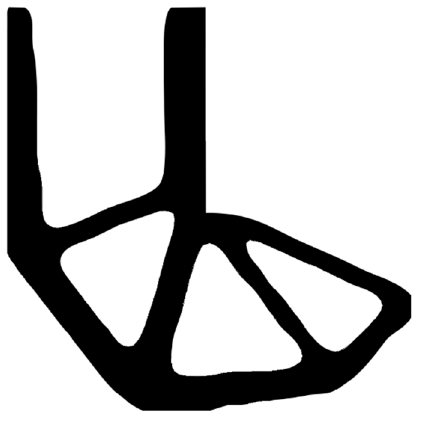
Figure 4. Preliminary optimized shape of L-shaped beam.